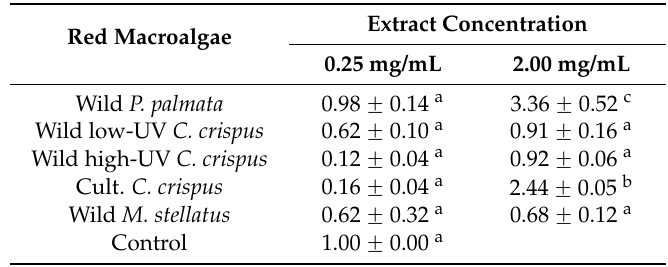
Table 3. Effect of wild-harvested and cultivated red macroalgal extracts on HeLa cell Caspase 3/7 activity 1 .